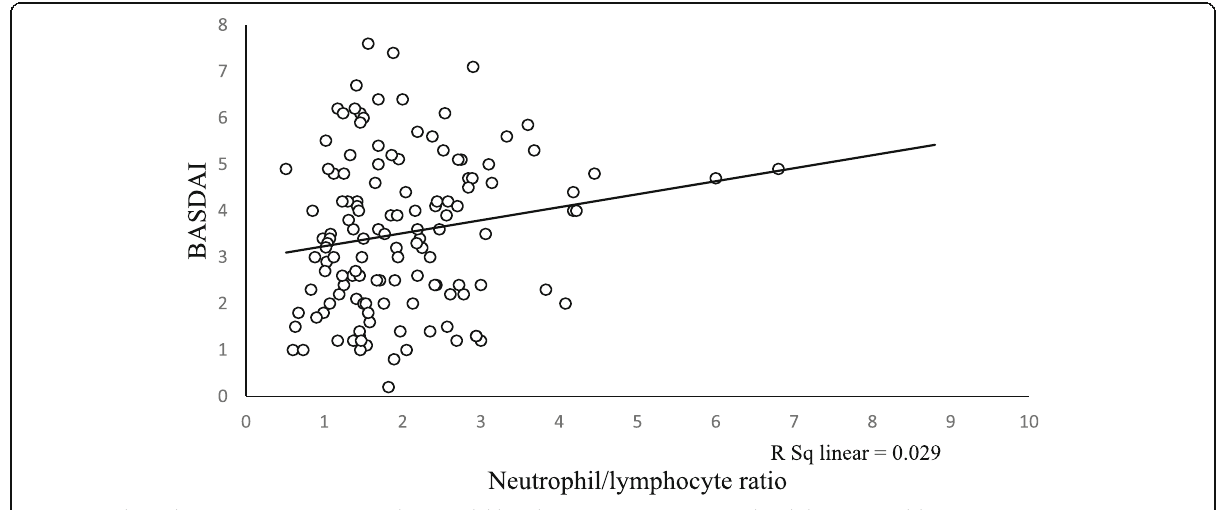
Fig. 3 Correlation between BASDAI scores and neutrophil/lymphocyte ratio in patients with ankylosing spondylitis ( p = 0.051)